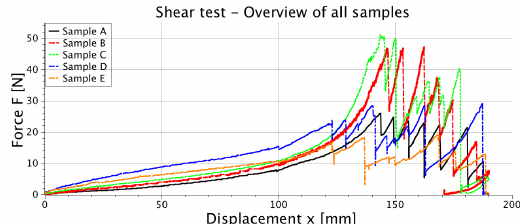
Figure 6. Raw-data of all samples; force F is plotted over displacement x .